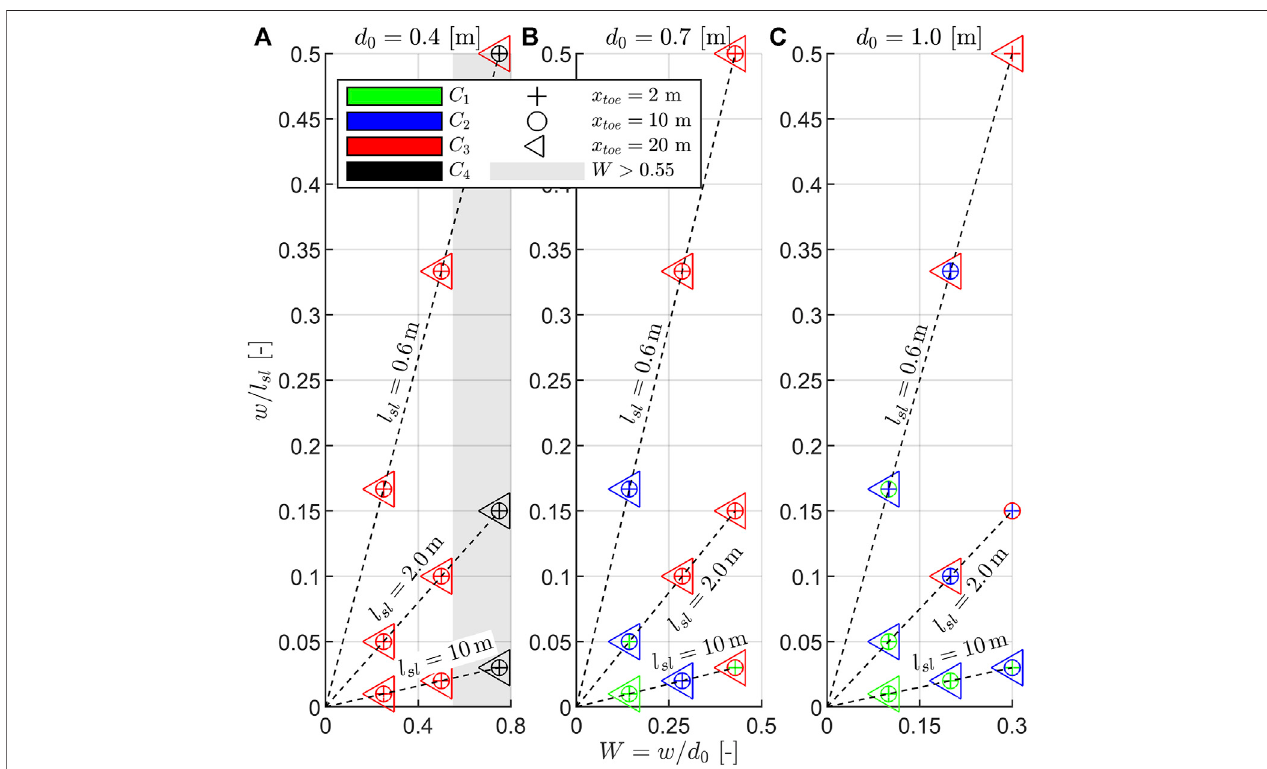
FIGURE 8 | Dimensionless visualization of the observed classes in relation to the composite bathymetries ’ parameters; slope steepness on the ordinate, dimensionless elevation of the horizontal plane ( W ) on the abscissa, and x toe indicated by markers and separated by initial impoundment depth (A-C) . Dashed lines indicate tests with equal slope length. Classes are indicated by colors. Gray-shaded area covers W -values larger than ~0.55 (only visible in (A) ), which is found to be a delimitation criterion above which no overland fl ow is observed (class C4; total re fl ection).